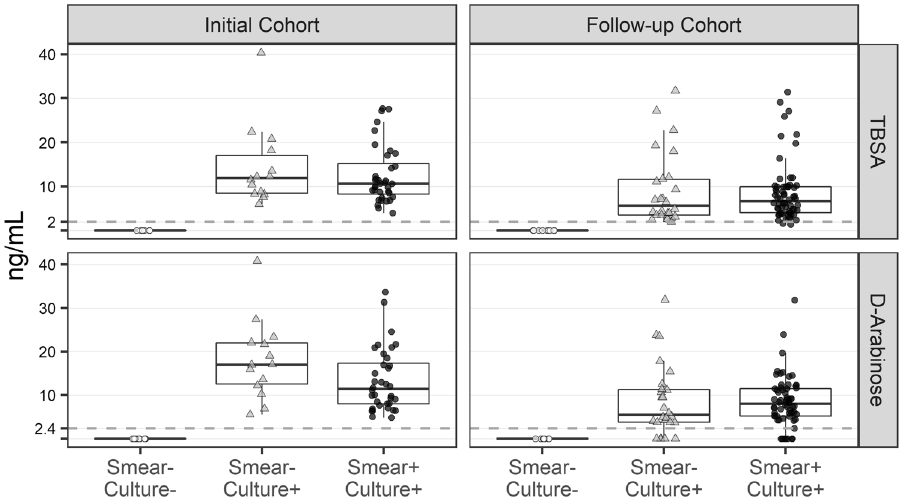
Figure 6. Correlation of smear− and smear+ category with LAM amounts in urine. For TBSA, the LoD is set to be 2 ng/mL below which the peaks are discernable and for d-ara 4 peaks must be present to conclude as positive. LoD for d-ara was found to be < 2.4 ng/mL. Both TBSA and d-ara must calculate out to be in similar amounts (± 5% error for manual integration). Overall, 138 of 140 TB-positive samples has LAM above LoD by TBSA (98.5%) and 127 has LAM by d-ara (90.7%). All 20 clinically TB negative samples had no LAM by either assay (Specificity >